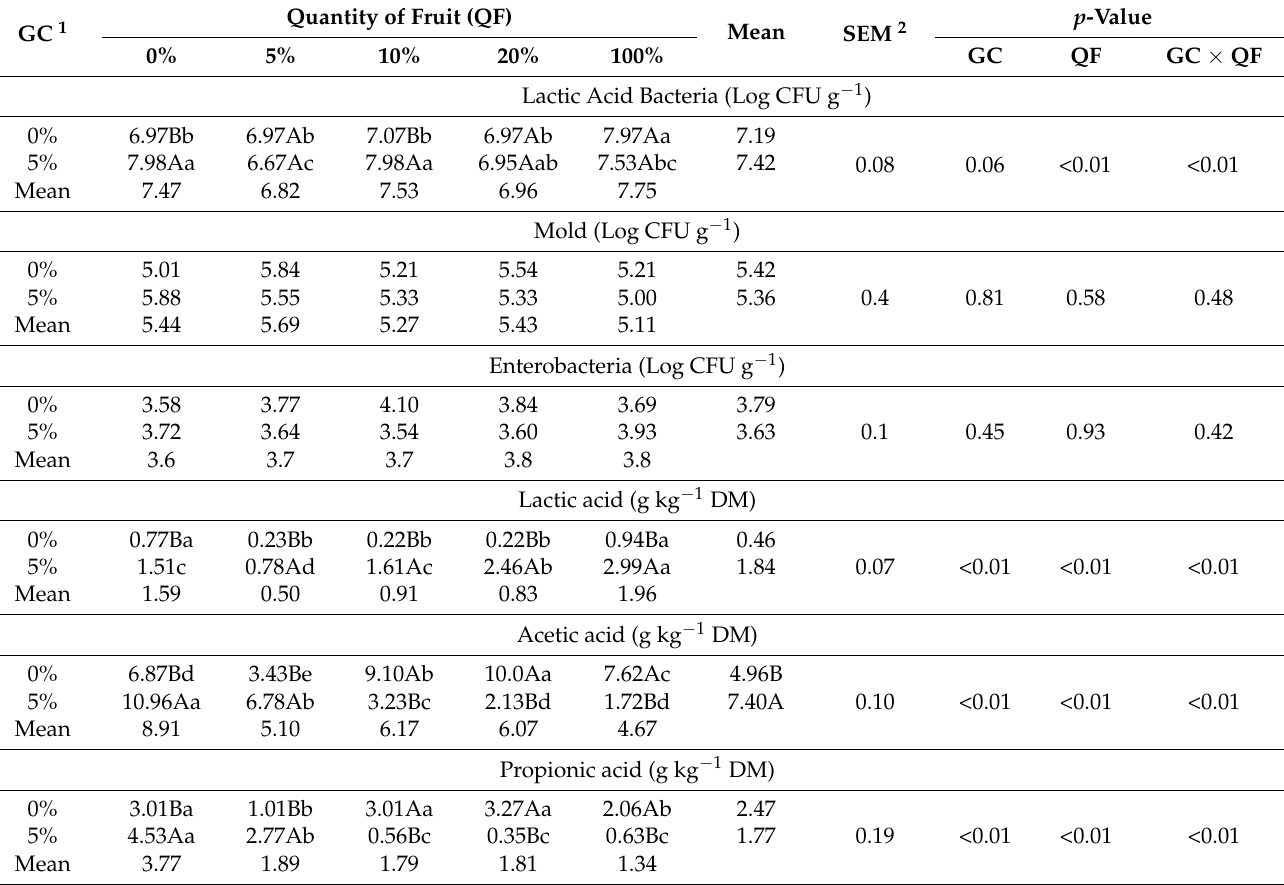
Table 2. Microbial populations, organic acids, and aerobic stability of silages with different mixtures of melon plant biomass with and without the addition of ground